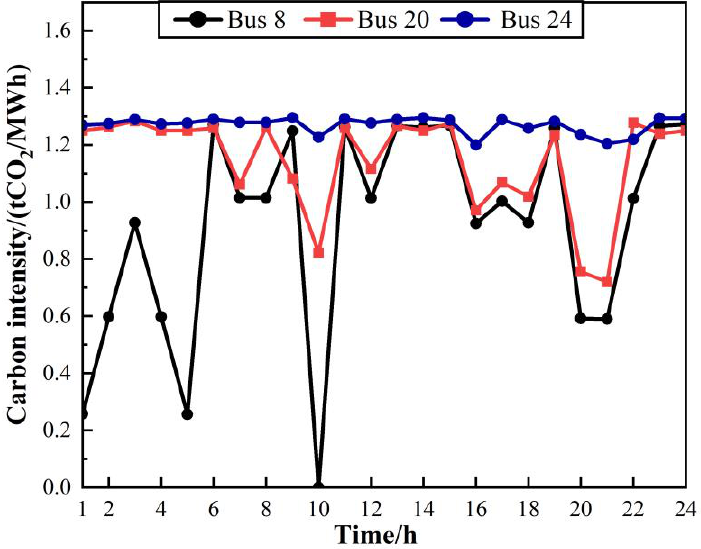
Figure 7. Bus carbon intensities at optional ES locations before planning.